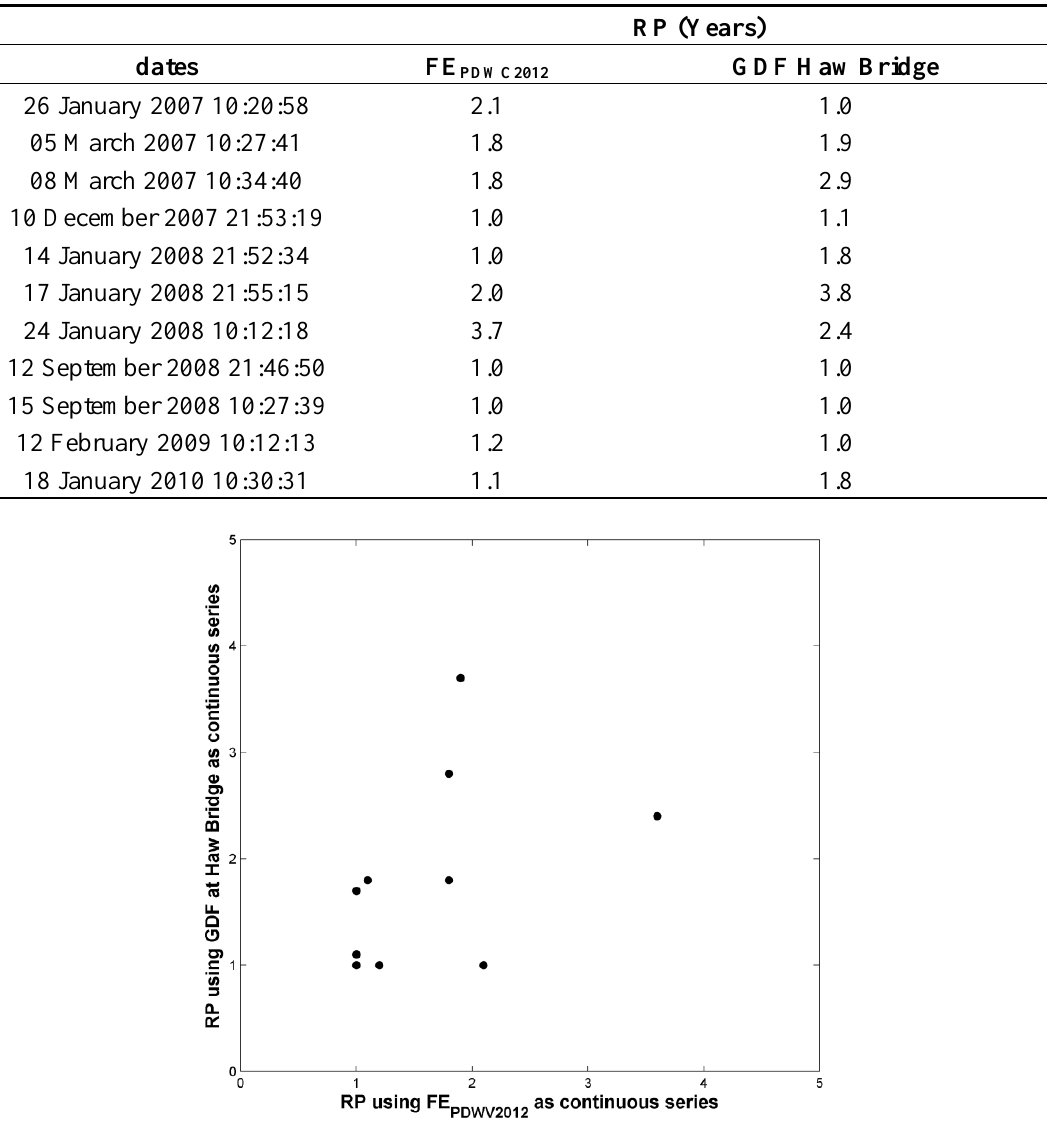
Table 4. RPs attributed to the different SAR-derived flood extent.